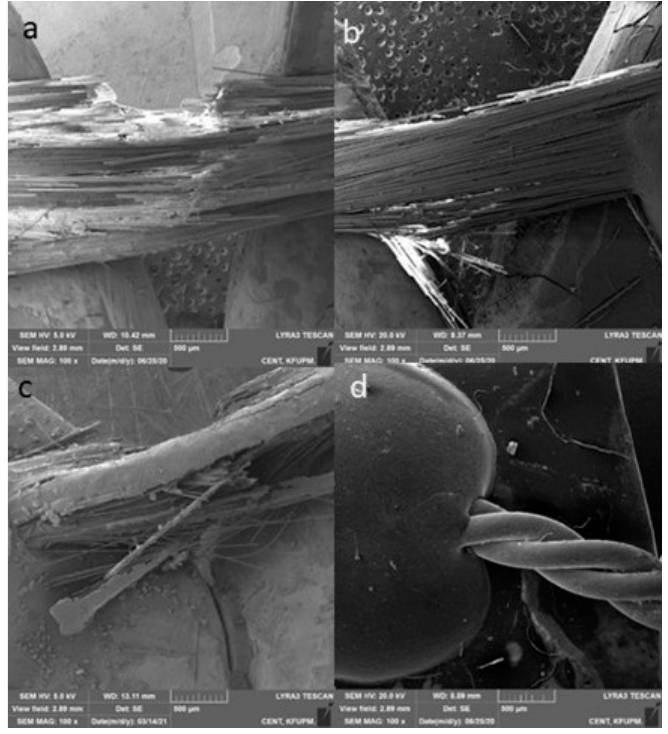
Figure 5. Representative images of ( a ) nHA/EG, ( b ) EG, ( c ) EST, and ( d ) SS retainers after fatigue testing.